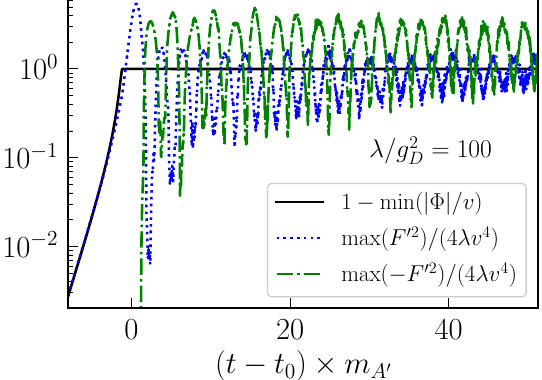
Figure 4 . Maximum and minimum field values as a function of time. We show the displacement from the VEV of the minimum scalar field magnitude (solid black line), which tracks the maximum of the field tensor contracted with itself F 0 2 (dotted blue line) closely during the linear instability phase. We also show the maximum values of − F 0 2 (dashed-dotted green line) when this quantity is positive. Here F 0 2 ≡ F 0 µν F 0 = 2( B 0 2 − E 0 2 ) , so F 0 2 > 0 corresponds to magnetic dominance, and µν F 0 2 < 0 corresponds to electric dominance.